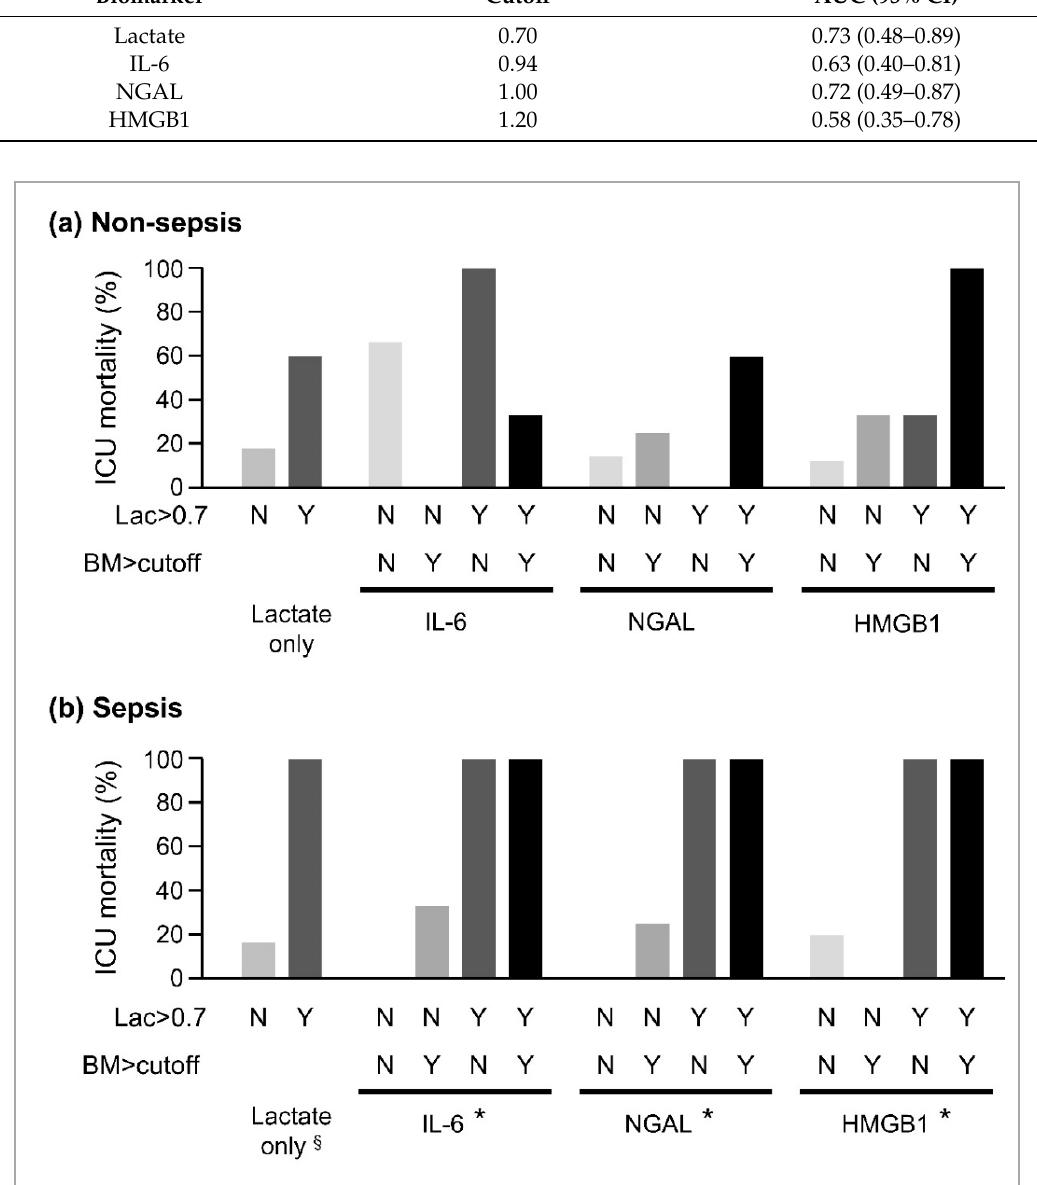
Table 2. The cutoff and area under the curve (AUC) of each biomarker for ICU mortality. Biomarker